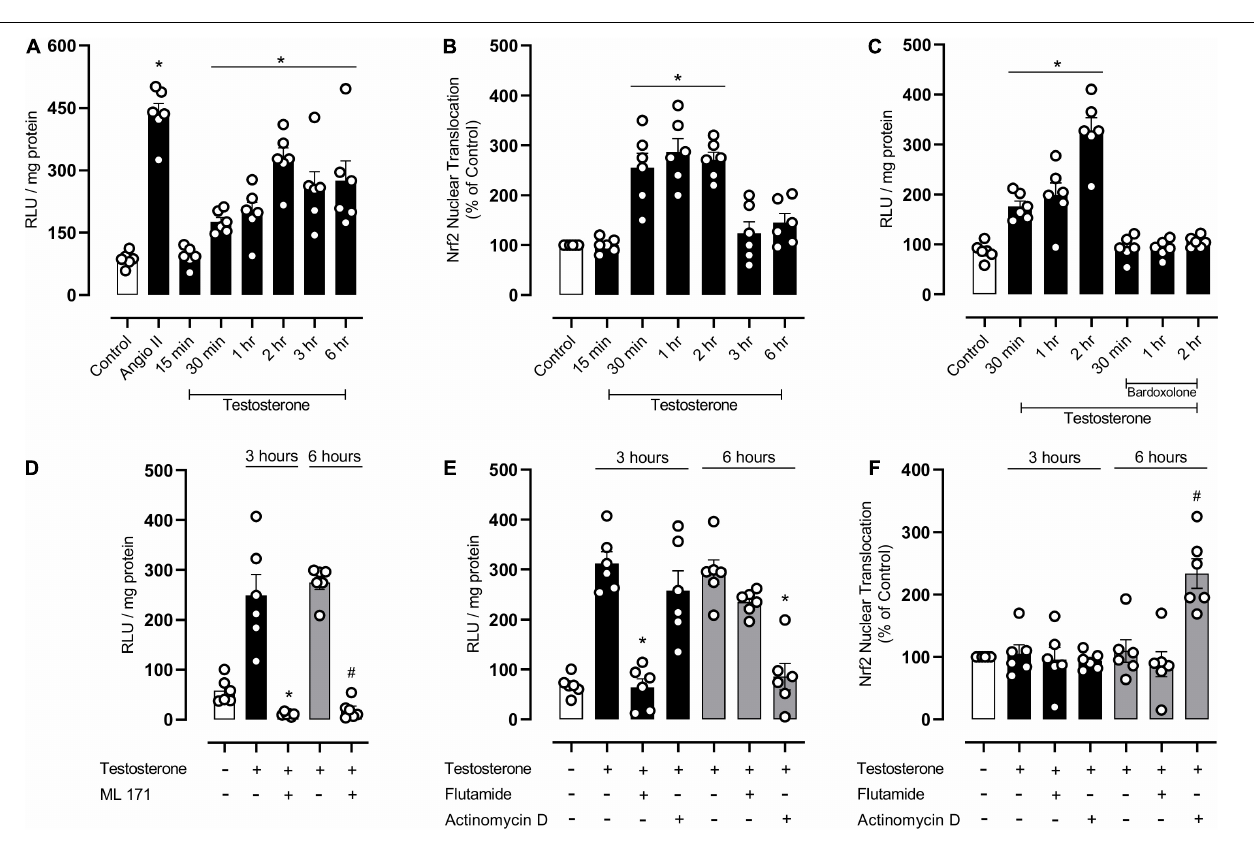
Frontiers in Physiology |